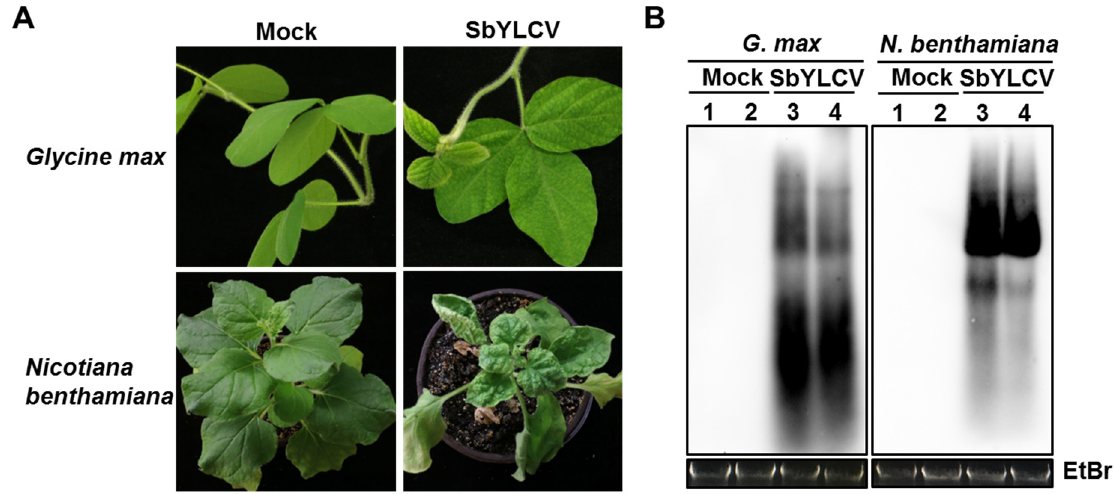
Figure 5. Systemic infection of SbYLCV in Glycine max and Nicotiana benthamiana plants. ( A ) Characteristic symptoms induced by SbYLCV. Plants were agroinoculated with the pBinPLUS vector (mock) or the infectious clone of SbYLCV, as indicated. Photos were taken at 30 days post-inoculation (dpi). ( B ) Southern blot hybridization analysis of SbYLCV DNA with a specific DIG-labelled DNA probe. Total DNA was extracted from systemic leaves of SbYLCV-infected and mock-inoculated plants, as indicated. Ethidium bromide staining of total DNA was used as loading controls. Table 2. The infectivity analysis of soybean yellow leaf curl virus.